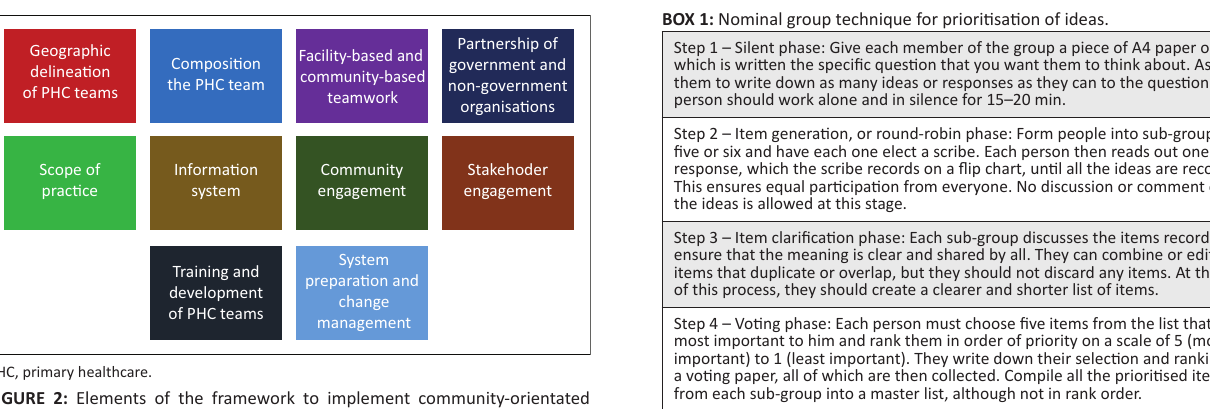
FIGURE 2: Elements of the framework to implement community-orientated primary care in Metro Health Services, Cape Town.